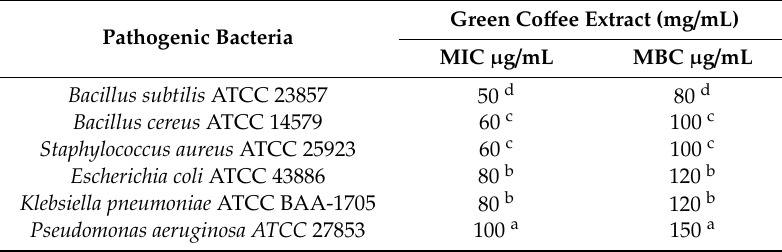
Table 9. MIC and MBC of the green coffee extract against six types of pathogenic bacteria. Pathogenic Bacteria